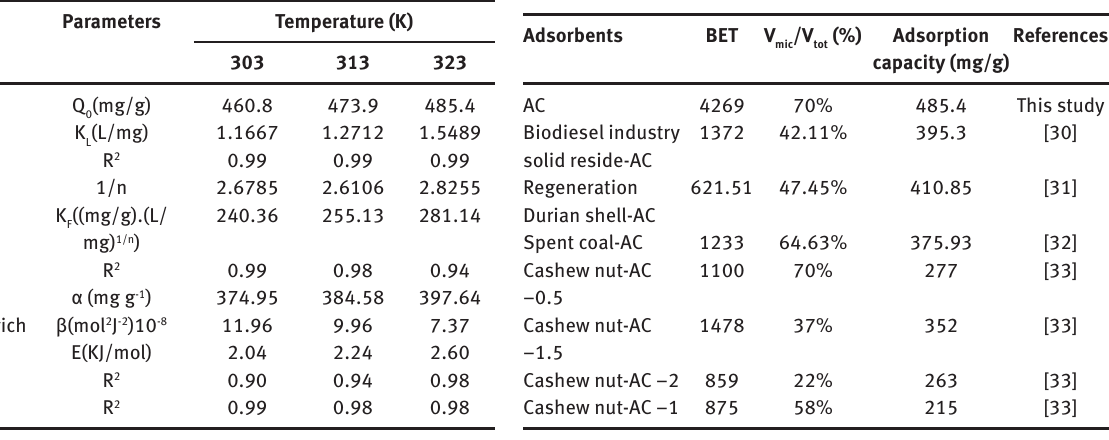
Table 4: The MB adsorption capability of the different kinds